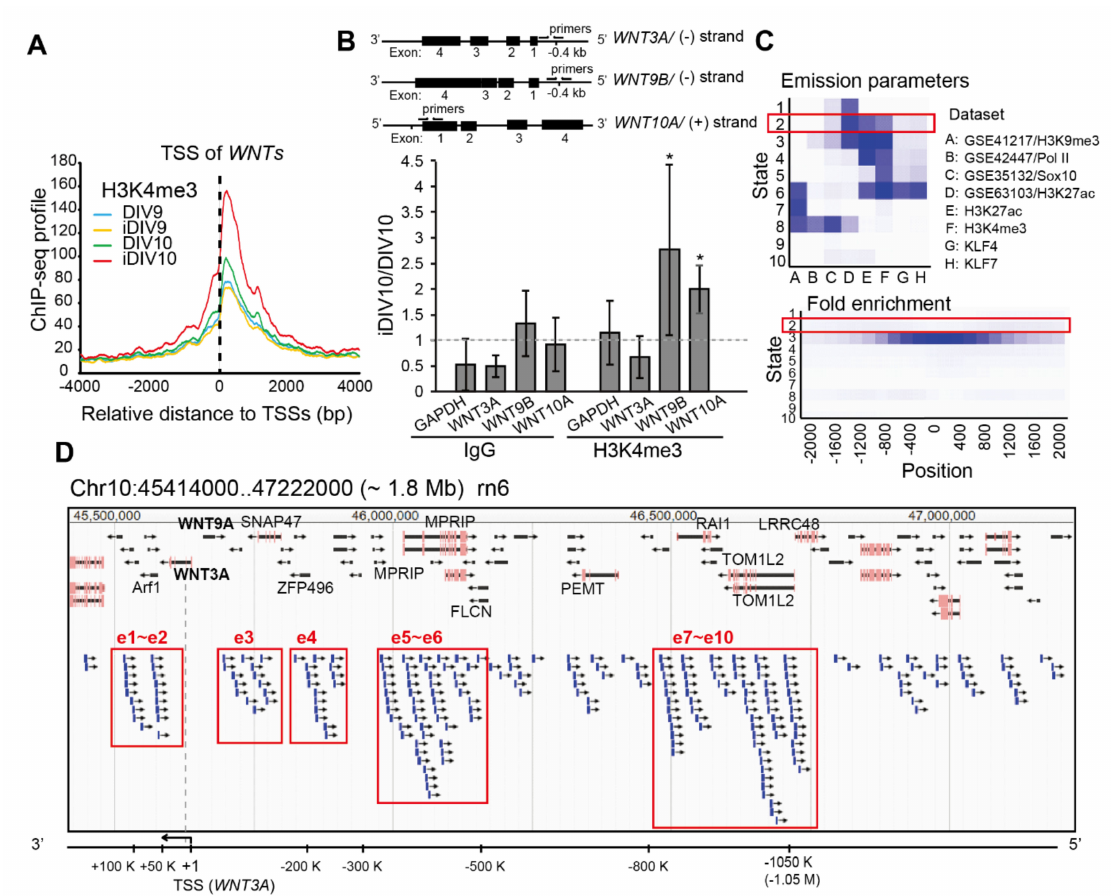
Figure 2. Prediction of putative enhancers of WNT3A gene. ( A ) Aggregation of normalized tri-methylation of histone H3 at lysine 4 (H3K4me3) signal density profiles of 88 WNT-related genes across the ± 4 kb promoter regions. H3K4me3 signals across control and injured samples are indicated by colored lines. ( B ) Upper: Schematic diagrams of gene track for rat WNT3A , WNT9B and WNT10A . Targeted loci at the promoters for specific primers used for ChIP assays are shown. Bottom: The fold change of H3K4me3 at the promoters of WNT3A , WNT9B or WNT10A in cortical neurons comparing DIV10 and iDIV10 were analyzed by ChIP-qPCR. The fold change of H3K4me3 at GAPDH promoter was used as a control. Data were normalized to IgG and then to DIV10 controls, indicated as fold change. Data are presented as mean ± SEM from three independent experiments. Gray dotted line indicates the fold change = 1. Enrichment of IgG or H3K4me3 across control and injured samples at the promoter of each WNT were compared independently, using two-way ANOVA followed by Tukey’s test. * P ≤ 0.05. ( C ) Functional enrichment of chromatin states in rat genome performed by ChromHMM. Upper: Heatmap of the model parameter with chromatin states numbered in the emission order. The columns refer to relative enrichment for the indicated annotation in corresponding chromatin states. ChIP-seq data from four Gene Expression Omnibus (GEO) datasets as well as data from this study were used to train the model. Bottom: Heatmap of the positional enrichment of annotated chromatin states. The genomic feature of the State2 elements is indicated in red boxes. Enrichment of H3 lysine 27 acetylation (H3K27ac) (shown in blue), low RNA polymerase II (RNAPII) occupancy (shown in white) and deficient State2 elements residing within proximal promoter regions (shown in very light blue) suggest their enhancer identify. ( D ) Snapshot of JBrowse Genome Browser demonstrating the region across 1.8 Mb flanking the WNT3A transcription start site (TSS) of the rat genome (RCSC 6.0 / rn6 ). Ten predicted genomic regions (e1-e10, indicated in boxed area) may be enhancers for the WNT3A gene based on the enrichment of clustered State2 elements assigned by ChromHMM. A diagram of WNT3A gene region is shown at the